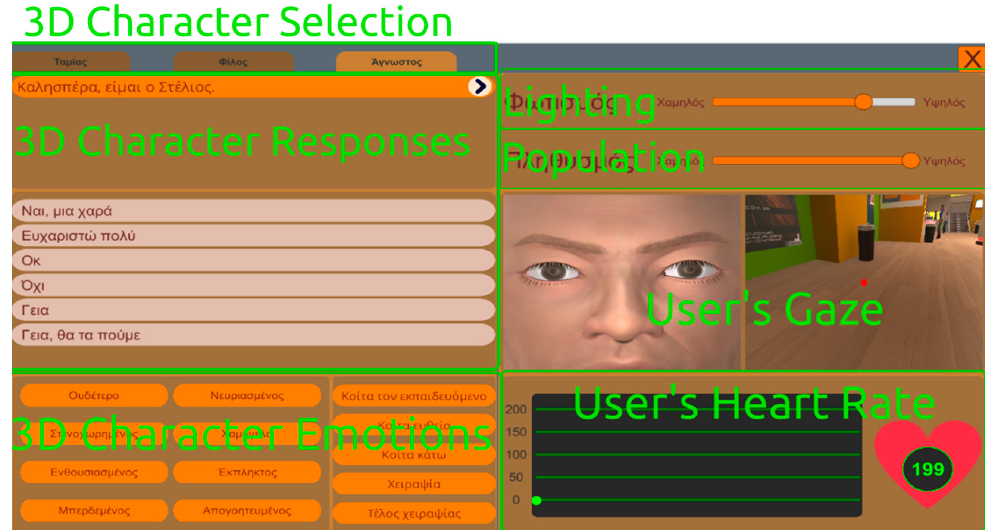
Figure 2. User Interface during the scenario for selecting the interacting 3D character ( Top Left ) and controlling the interacting 3D character’s responses ( Middle Left ) and emotions ( Bo tt om Left ) and the lighting intensity and NPC population density ( Top Right ) in the virtual environment, as well as for observing the user’s gaze ( Middle Right ) and heart rate ( Bo tt om Right ).